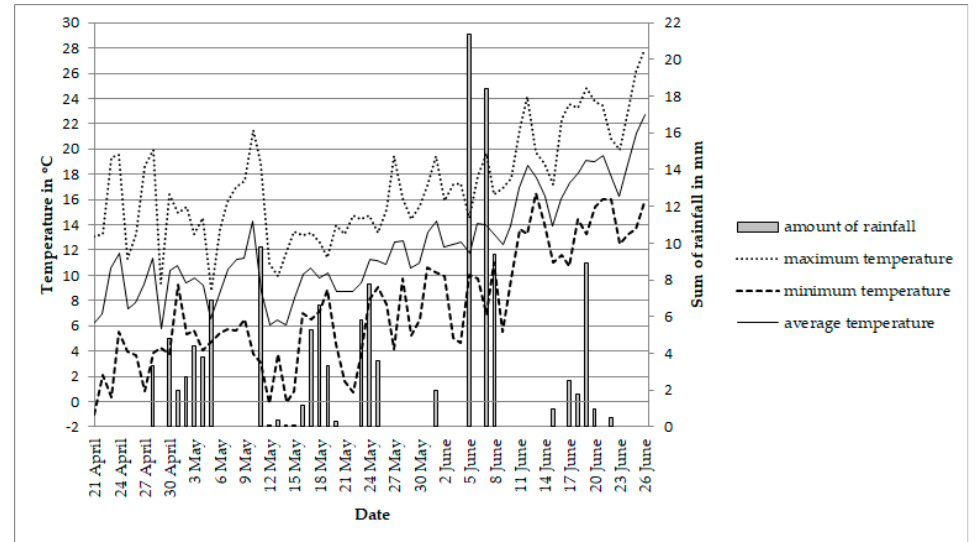
Figure 1. Meteorological data obtained within the period of observation in 2020.